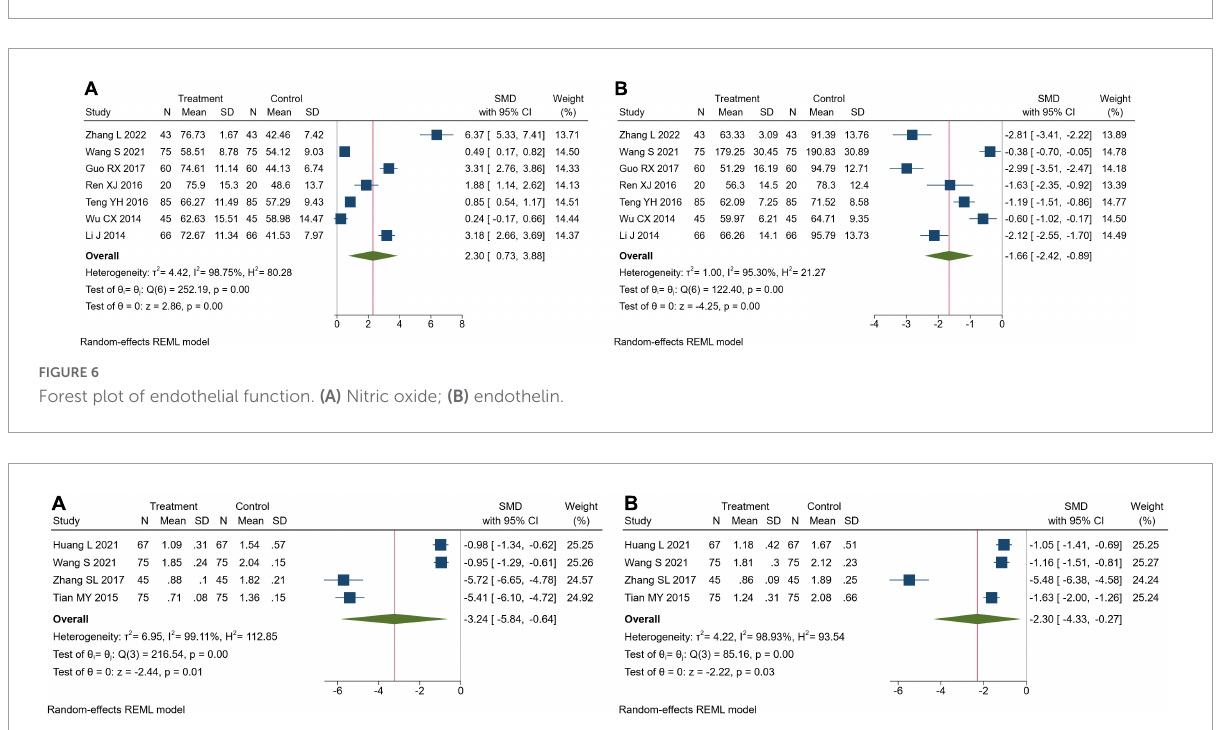
FIGURE5 Forest plot of blood lipids. (A) Total cholesterol; (B) triglyceride; (C) low-density lipoprotein cholesterol; (D) high-density lipoprotein cholesterol.